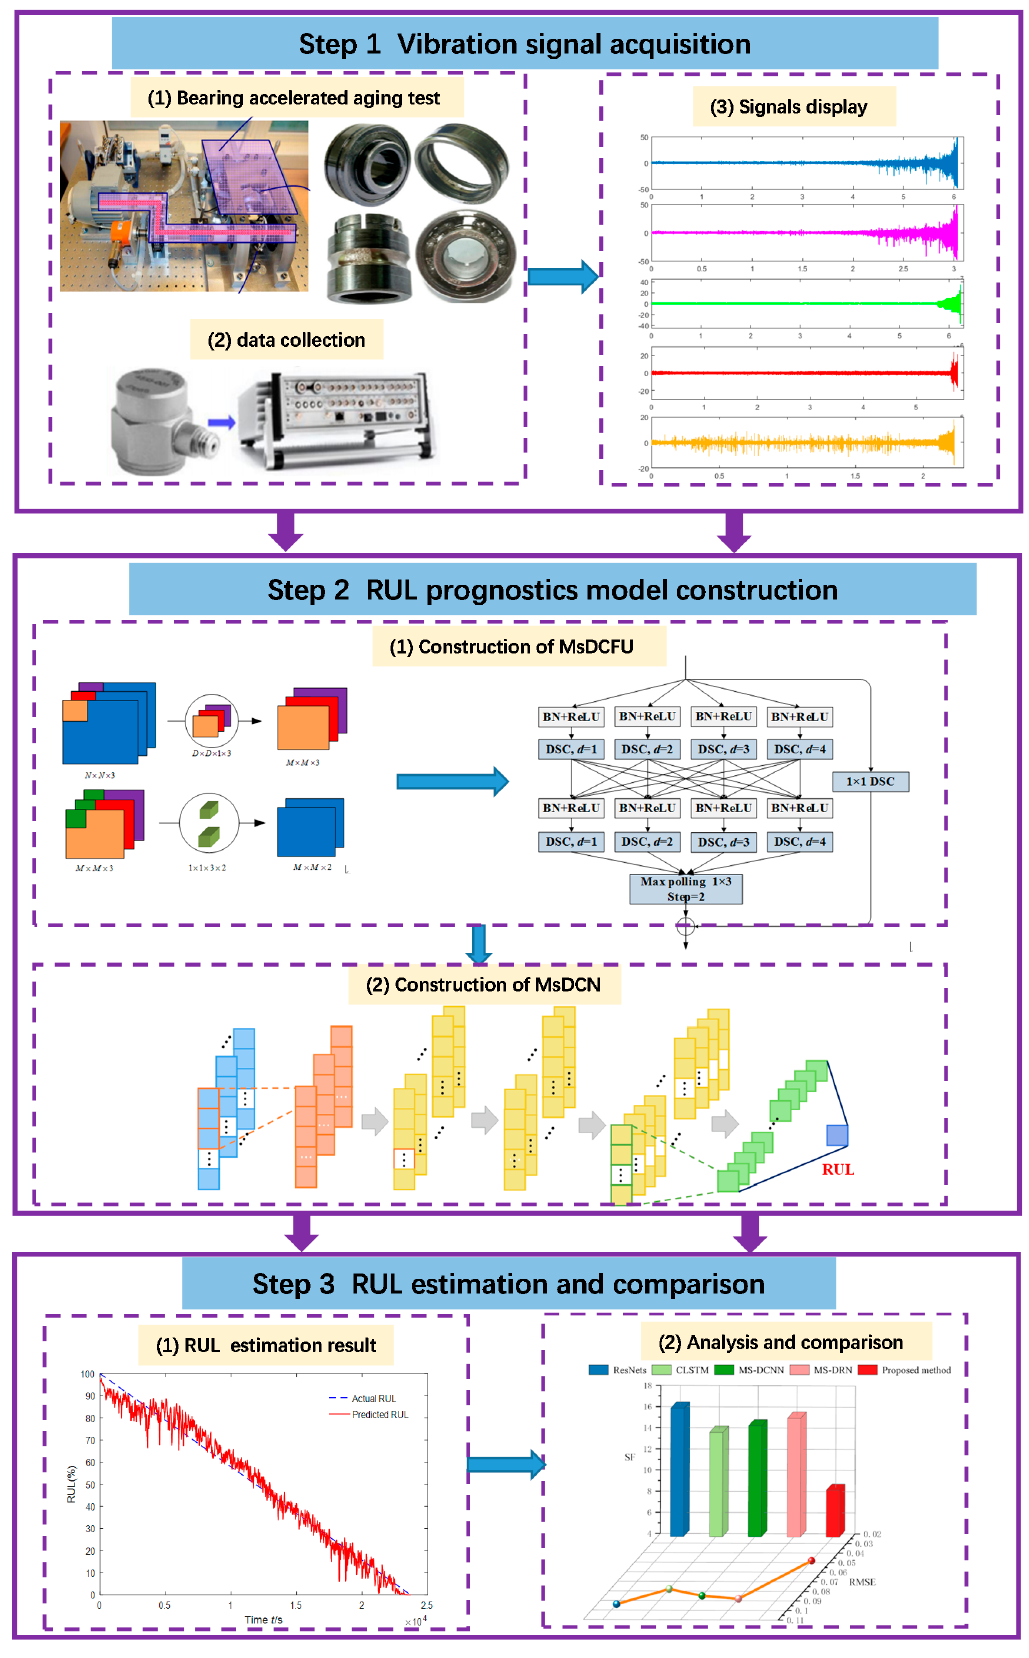
Figure 1. Sketch map of the proposed method.